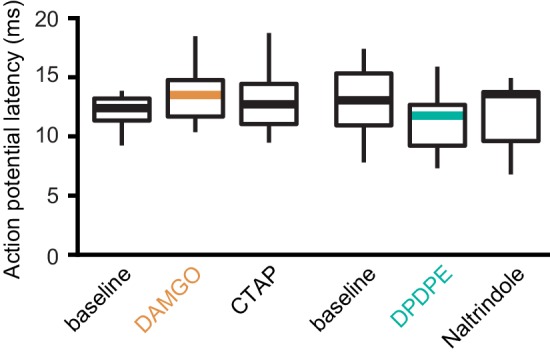
Latencies of thalamocortical-evoked action potentials in ACC pyramidal neurons.The average latency to the first action potential following optical stimulation of the MThal inputs recorded in layer 5 (L5) pyramidal neurons (Pyr), using loose cell-attached configuration. There were no significant differences in the latency to the first spike. DAMGO: N = 3, n = 7; CTAP: N = 3, n = 7, SM = 2, p = 0.368; DPDPE: N = 4, n = 8; naltrindole: N = 4, n = 8, SM = 1.75, p = 0.417. Box plot with median, 1st and 3rd quartile, and whiskers represent 1.5 times interquartile range. SM: Skillings-Mack statistic.